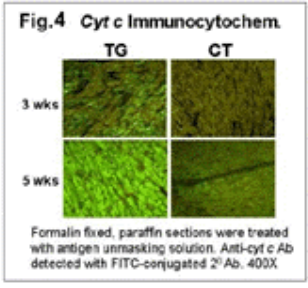
Fig. 4: All myocytes receive protection from apoptosis. The anti-apoptotic protein Bcl-2 is upregulated in all myocytes in transgenic mice with mtDNA mutations (TG), as seen by immunofluorescence. In fact, even dying cells (TUNEL positive; red) show increased Bcl-2 expression, and therefore do not have a relative deficiency of Bcl-2-like